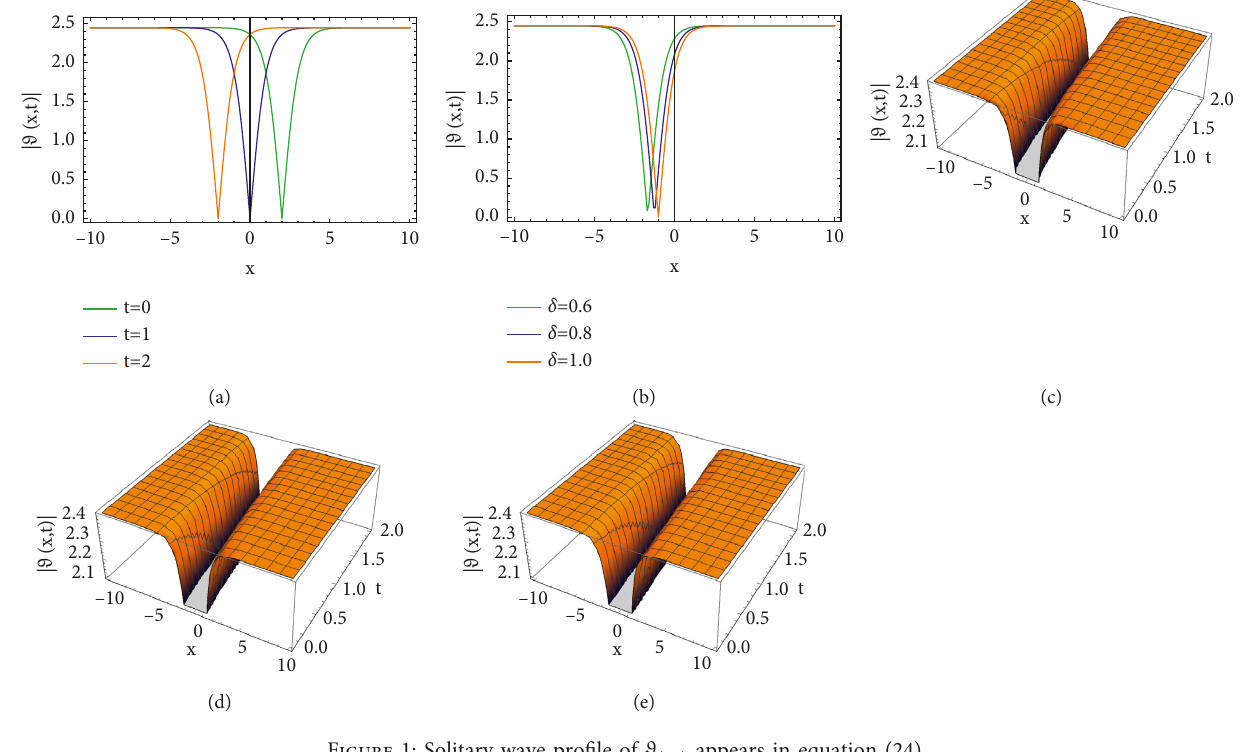
appears in equation (24). x,t ( )